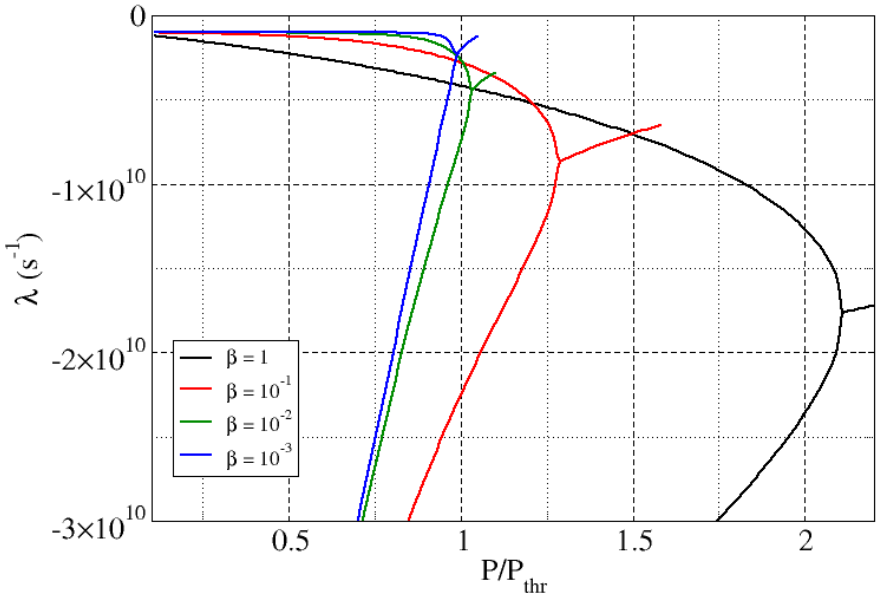
Figure 4. Real part of the eigenvalues derived from the stability analysis of the rate equations model, Equations (12) and (13). The different curves belong to different values of the fraction of spontaneous emission coupled into the lasing mode (cf. figure